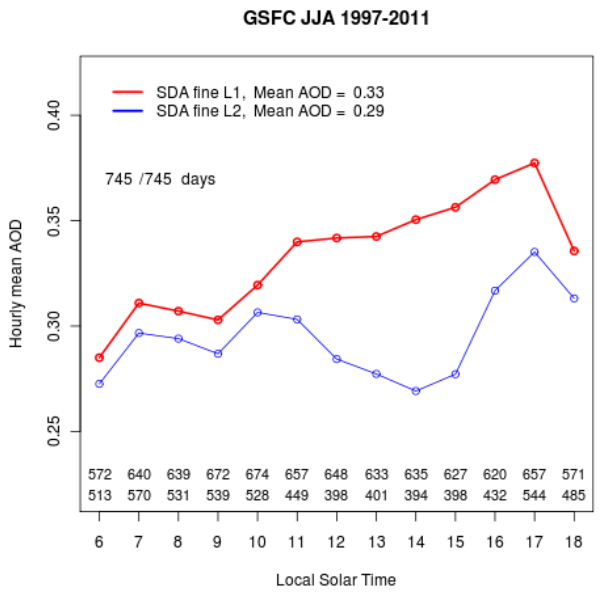
Figure 17. Hourly mean fine mode AOD for the GSFC site clima- tology (1997–2011) for the summer months (June through August). The red line shows data with no cloud screening (Level 1) com- pared to the blue line with cloud screened data (Level 2 Version 2). A total of 745 days were analyzed, with the values above the x axis showing the number of days for each hour, with the upper numbers for the Level 1 data and the lower for the Level 2